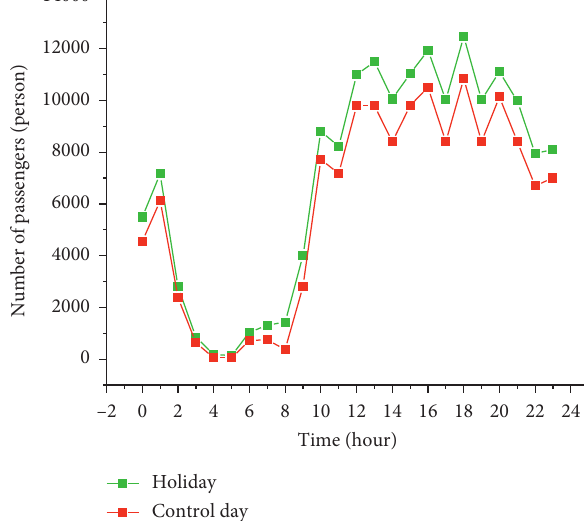
Figure 8: Comparison of the passenger number on control day and